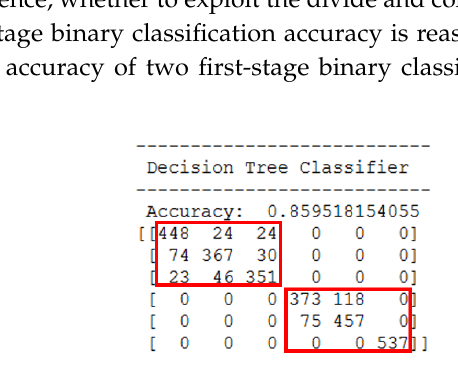
Figure 3. Confusion matrix of decision tree classifier on 6-class HAR. For some pairwise activity classes, there are no misclassified instances as indicated by the positions with zeros in the confusion matrix.